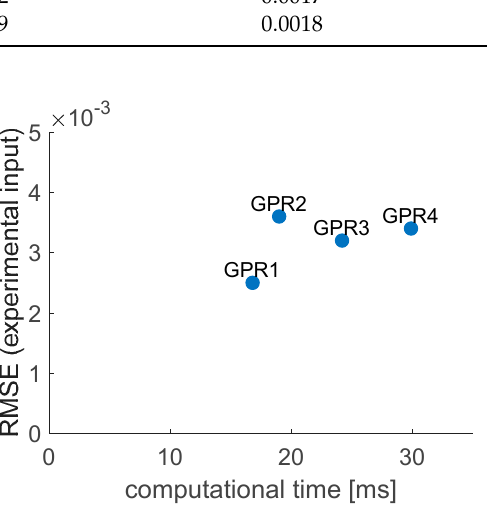
Figure 11. Results of testing GPR models: ( a ) load case LC1, numerical input data; ( b ) load case LC1, experimental input data; ( c ) load case LC2, numerical input data; ( d ) load case LC2, experimental